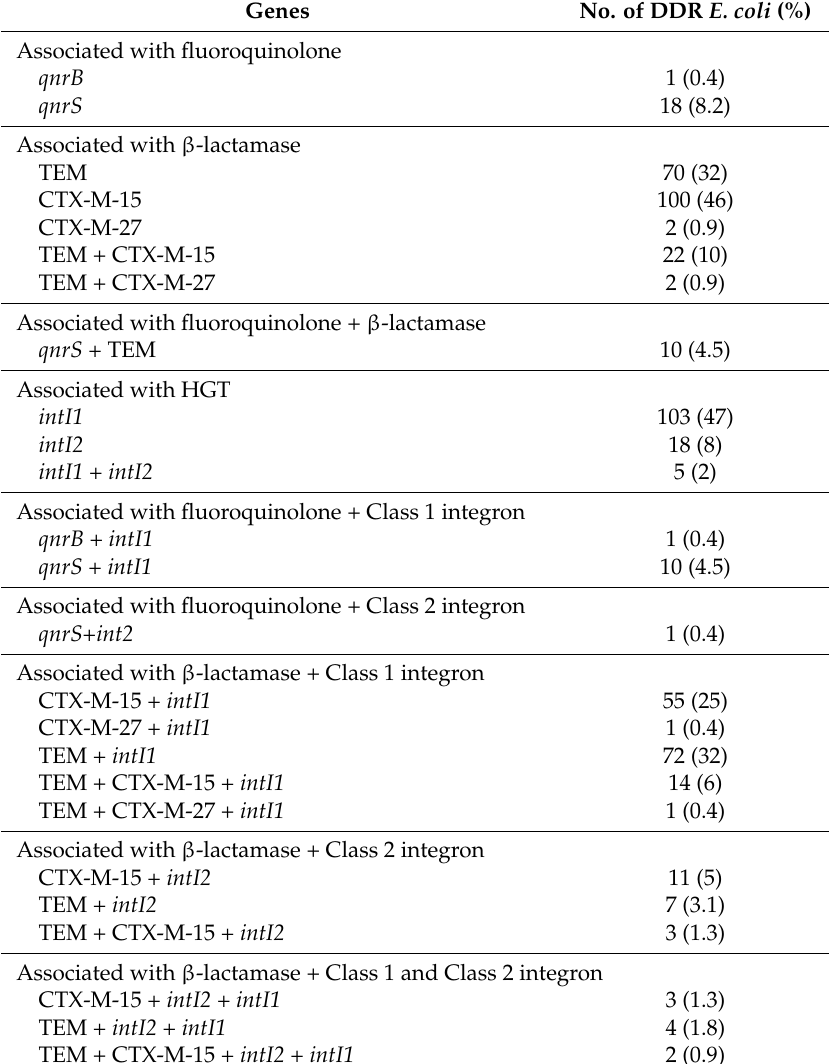
Table 4. DDR E. coli (%) detected with specific resistance and/or with integrons. Genes No. of DDR E. coli